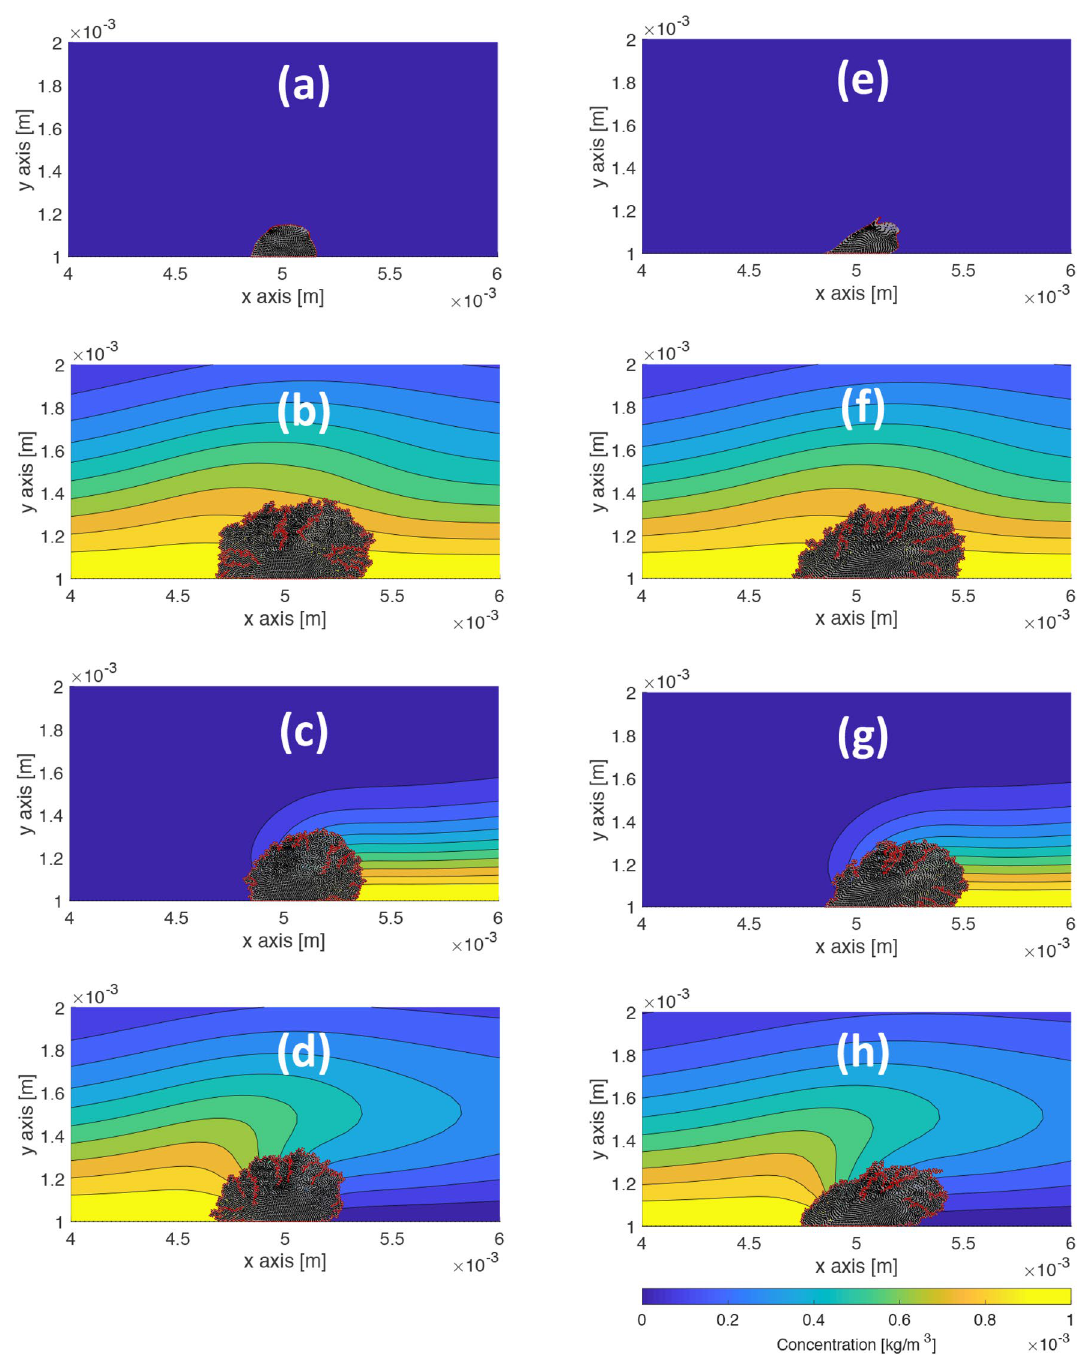
Figure 3. Comparison of growth and deformation in nutrient configurations and shear flow between an elastic biofilm ( E = 50 Pa) and a viscoelastic biofilm ( E = 50 Pa, η = 5 × 10 4 Pa s) after 2.5 h. The red lines indicate the boundary of the biofilm determined with the MATLAB function polyshape. ( a )–( h ) Top to bottom: no-concentration, full-stream concentration, downstream concentration, upstream concentration. ( a )-( d ) Elastic biofilm. ( e )-( h ) Viscoelastic biofilm. The viscoelastic biofilm grows further downstream than the elastic biofilm in each nutrient